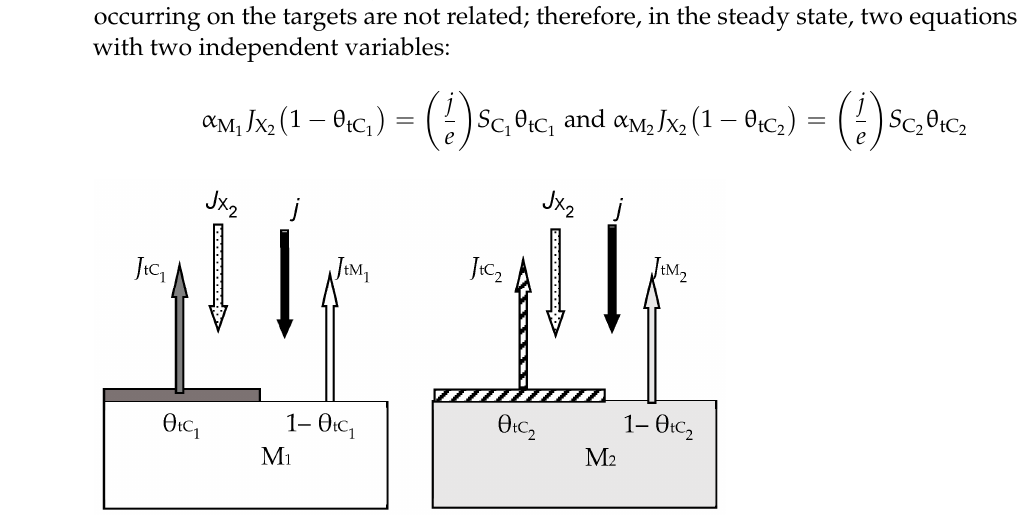
Figure 7. The fluxes on the substrate surface. Notations: J sM is the flux density of metal atoms M 1 ; J sM is the flux density of metal atoms M 2 ; J sC is the flux density of M 1 X molecules; J sC2 is the flux density of M 2 X molecules; θ sM is the fraction of the substrate surface covered by the metal film M 1 ; θ sM 2 is the fraction of the substrate surface covered by the metal film M 2 ; θ sC is the fraction of the substrate surface covered by the compound film M 1 X; θ sC2 is the fraction of the substrate surface covered by the compound film M 2 X.